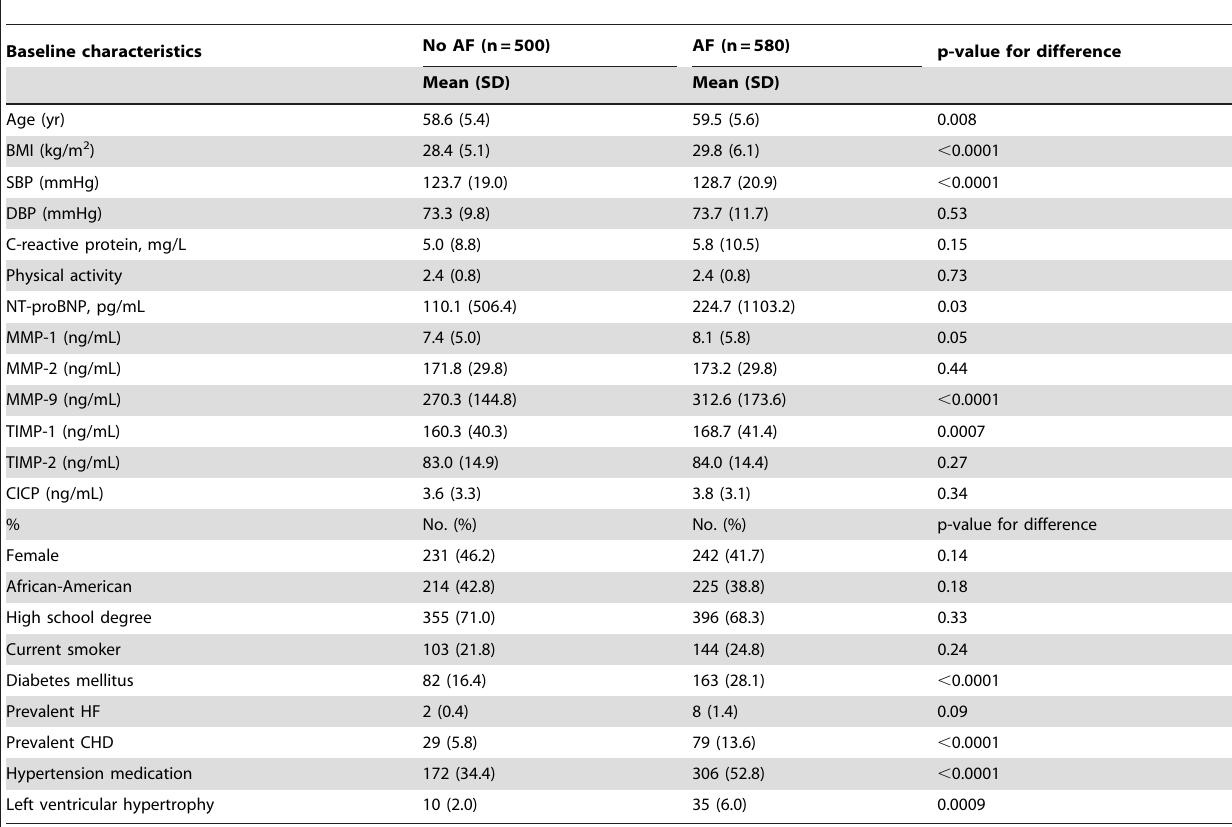
Table 1. Baseline characteristics (Visit 2) in the participants who developed atrial fibrillation (AF) during follow-up and those who did not, ARIC,